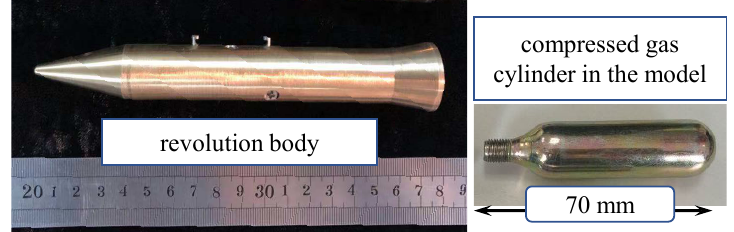
Figure 3. Test model and high-pressure cylinder.